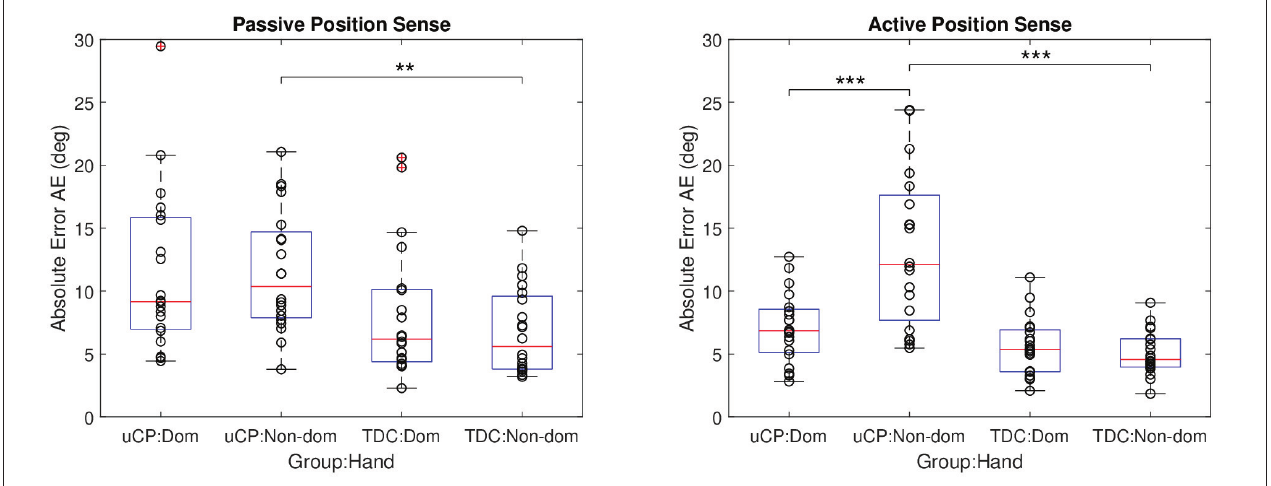
FIGURE 8 | Comparison between hands for active and passive position sense. Data from both test sessions are considered together for each group ( N = 20). Dom, dominant; non-dom, non-dominant hand. The stars indicate the following significance: ** < 0.01 and *** <